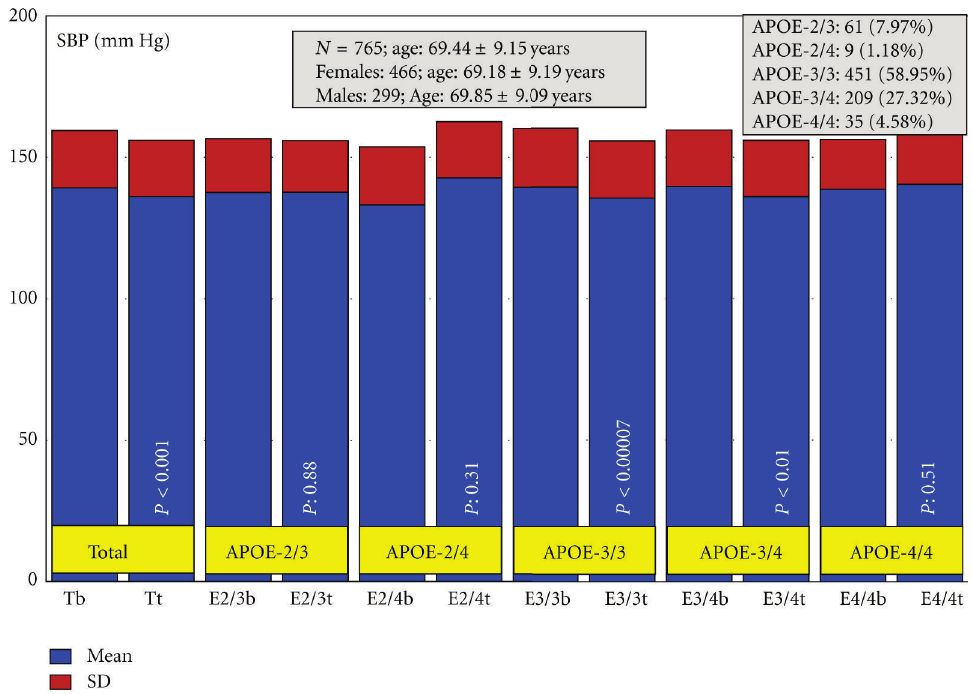
Figure 3: APOE -related systolic blood pressure response to a multifactorial therapy in patients with dementia. Tb: basal systolic blood pressure (SBP) prior to treatment; Tt: SBP after 3 months of treatment in the total sample. E2/3b: basal SBP in APOE-2/3 carriers; E2/3t: SBP after treatment in APOE-2/3 carriers; E2/4b: basal SBP in APOE-2/4 carriers; E2/4t: SBP after treatment in APOE-2/4 carriers; E3/3b: basal SBP in APOE-3/3 carriers; E3/3t: SBP after treatment in APOE-3/3 carriers; E3/4b: basal SBP in APOE-3/4 carriers; E3/4t: SBP after treatment in APOE-3/4 carriers; E4/4b: basal SBP in APOE-4/4 carriers; E4/4: SBP after treatment in APOE-4/4